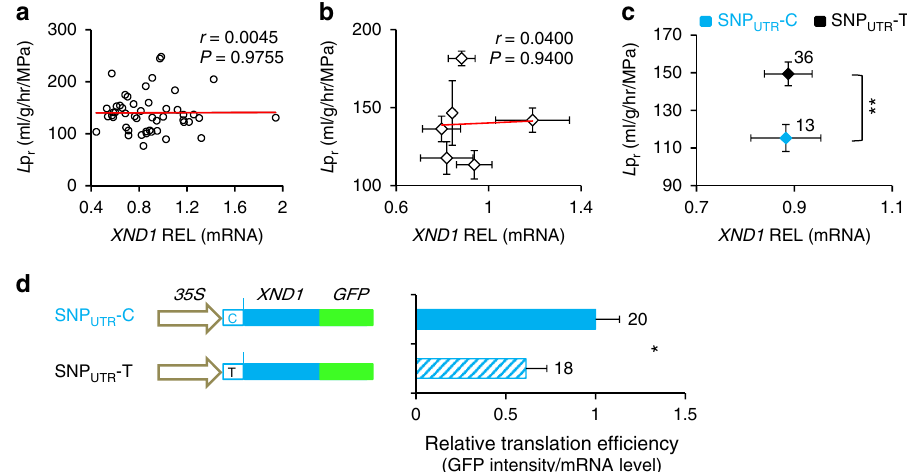
Fig. 4 XND1 -dependent natural variation of L p r is contributed by effects of SNP UTR on XND1 translation. a – c XND1 transcript abundance was measured in the roots of 49 accessions using 6 – 10 plants and two independent experiments per accession. Data were analyzed considering each individual accession ( a ) or their grouping in the H1-H6 ( b ) or SNP UTR -C vs. SNP UTR -T haplogroups ( c ). Pearson correlation coef fi cient ( r ) and P value ( P ) between XND1 transcript level and L p r are shown in a and b . Error bars in b and c indicate SE. Accession number per haplogroup was n = 3 – 18 in b and as indicated in c ( ** P < 0.01 in Student ’ s t test). d A XND1 – GFP fusion construct was placed downstream of a CaMV35S promoter and a XND1 5 ’ -UTR, with either C or T